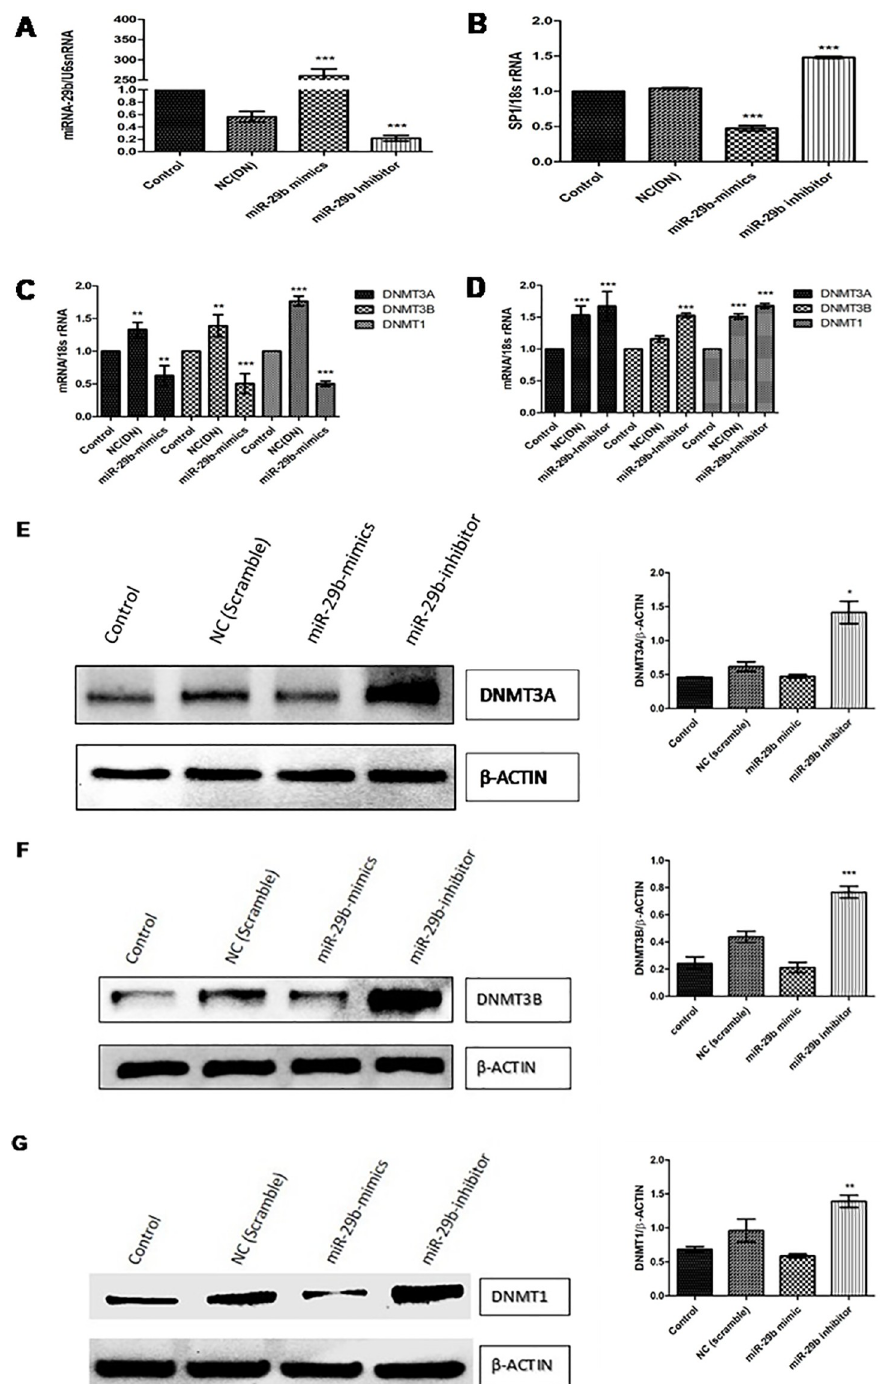
Fig 5. miR-29b modulates expression of DNMT3A, DNMT3B,DNMT1 and SP1 in RPTECs. A: Transfection efficiency of miR-29b mimics and inhibitor analysed by RT-PCR B, C and D : Effect of miR29b mimics and inhibitors on mRNA expression levels of SP1, DNMT3A, DNMT3B and DNMT1 respectively in DN model analysed by Real- time PCR. E, F and G: Assessment of protein levels of DNMT3A, DNMT3B and DNMT1 in control, negative control (Transfected with scramble vector) and DN model (transfected with miR29b mimics and inhibitors) performed by Western Blotting (n: 3), � indicates ‘p’ value < 0.05, �� indicates ‘p’ value < 0.01, ��� indicate p value < 0.001.